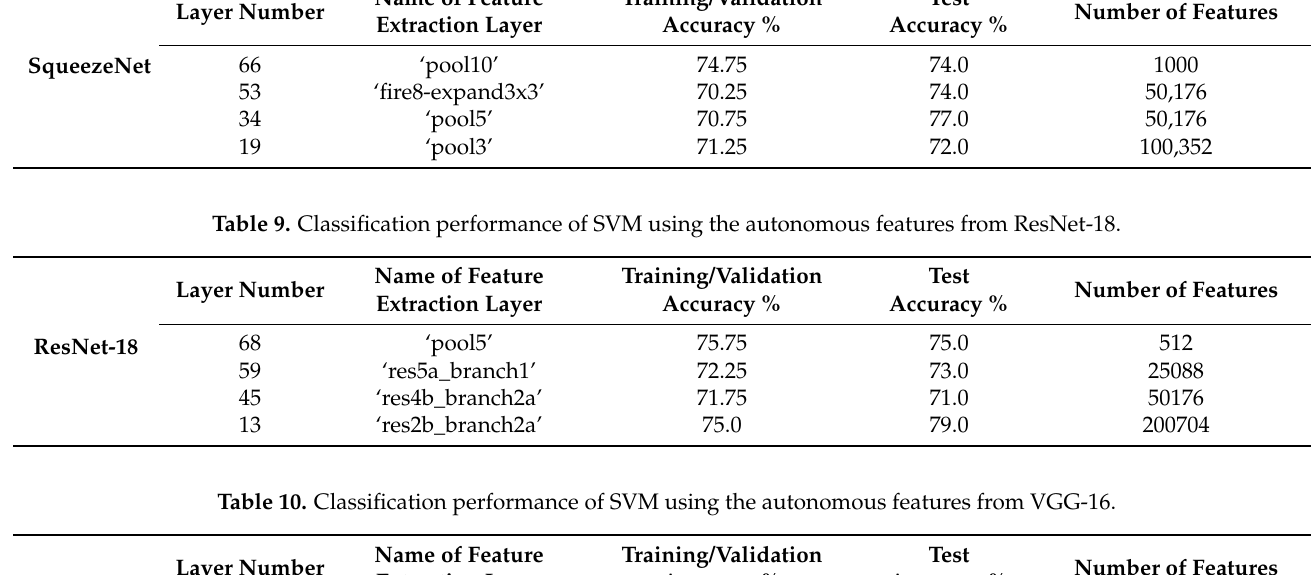
Table 10. Classification performance of SVM using the autonomous features from VGG-16.